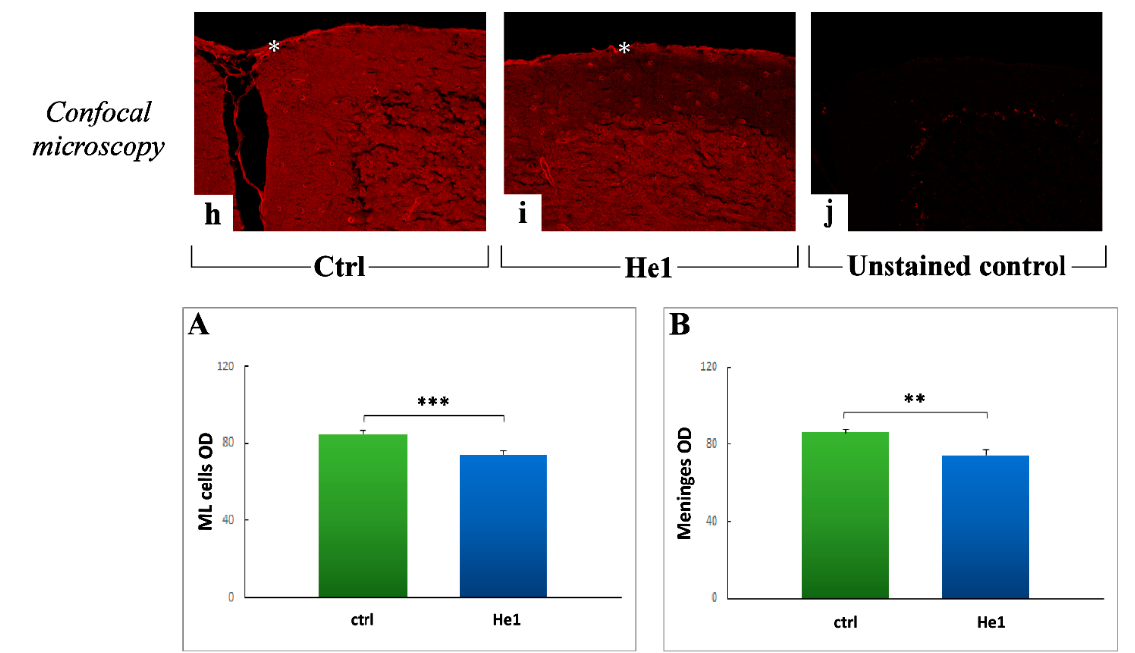
Figure 6. Representative PSR-stained cerebellar specimens, in untreated ( a – c , h , j ) and He1-treated mice ( d – g , i ) investigated by both light and confocal microscopy. Magnification: 40× ( a – e , h – j ); 100× (insert in c , f , g ). Panels ( A , B ) Histograms showing the quantitative analysis of histochemically positive ML cells and meningeal fibers OD, respectively. p values calculated by unpaired Student’s t -test: (**) < 0.01, and (***) < 0.001. Asterisks in a – e , h – i : meningeal fibers.